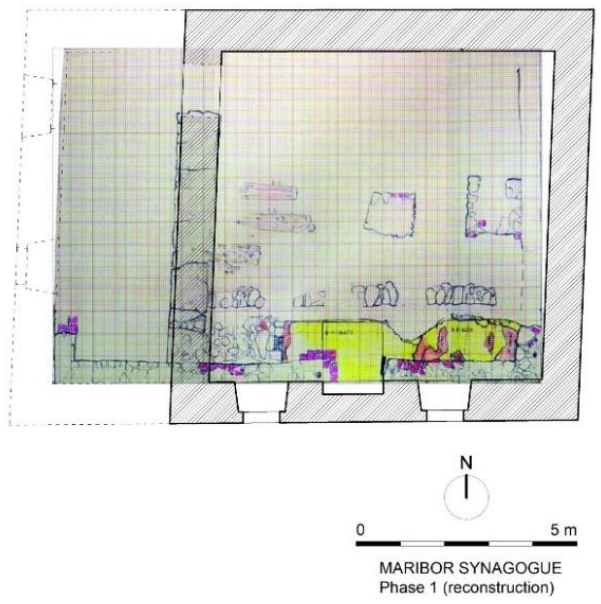
Figure 15. Archaeological sketch of the findings inserted into the ground plan of the first synagogue phase. Archaeological sketch: Mihela Kajzer Cafnik, 1994. Yellow designates screed, and red stands for brown soil. The walls are built with stone and mortar; purple designates brick. The archeological chart clearly reveals the first structure, as shown by the overlaying groundplan. The unearthed foundation of the western wall with the three other sides form an almost square space. The most intriguing finding is the screed (yellow), which is extended precisely into the southern wall to the niche, located in the wall of the reconstructed hall. It points to the southward positioning of the first synagogue, a deviation from the usual eastward orientation. The narrow wall, running parallel to the southern wall, was most likely used as support for a wooden defense system.